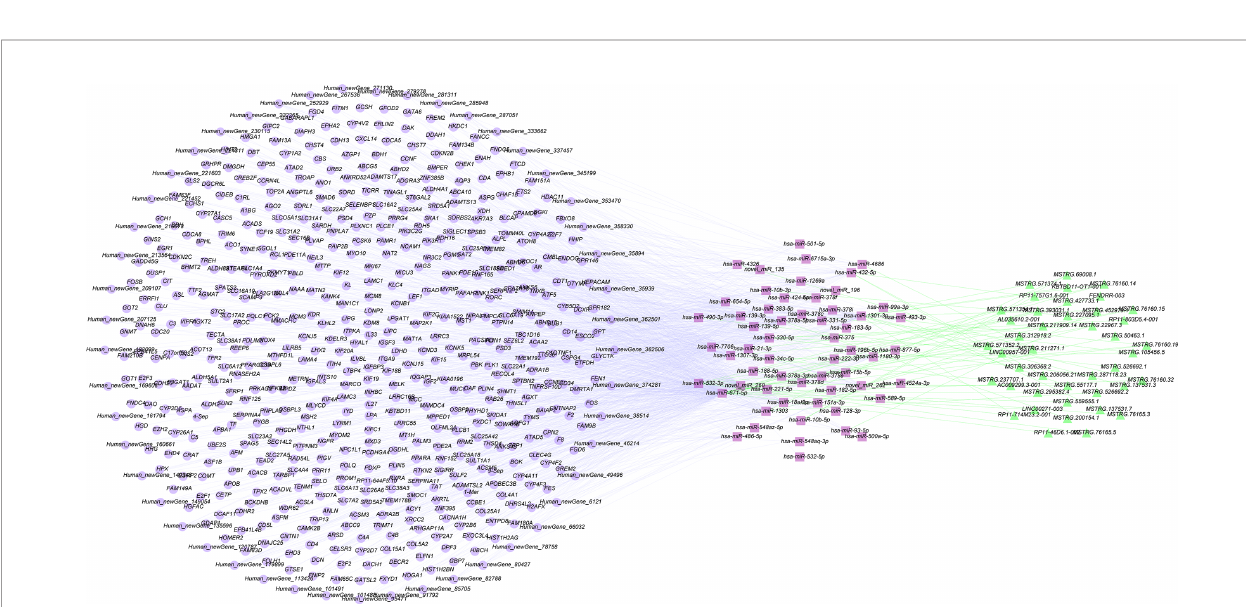
FIGURE 5 | Construction of ceRNA networks by differentially expressed mRNAs, miRNAs and